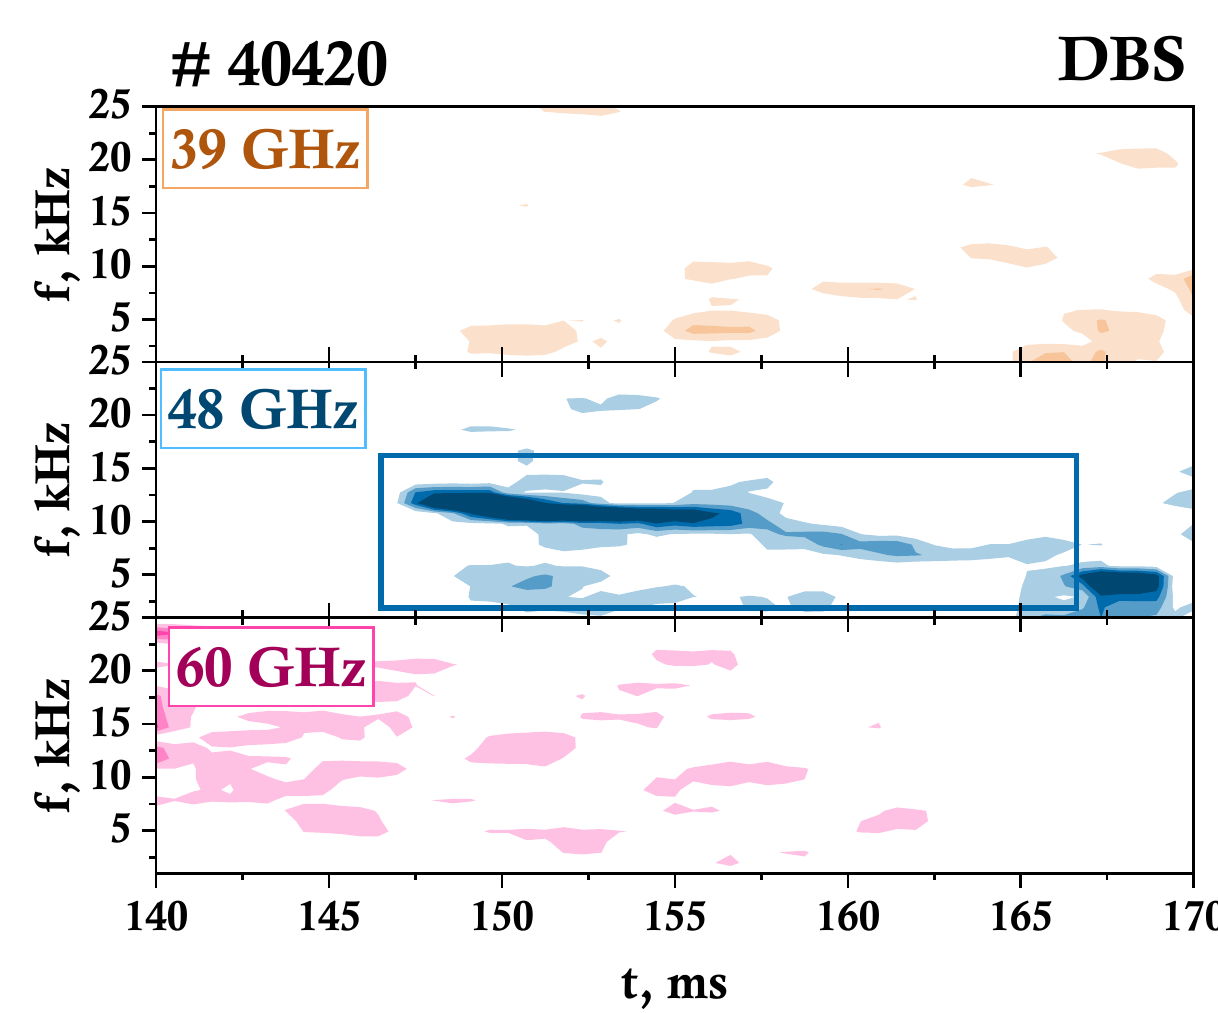
Figure 3. Spectrograms of the DBS phase derivative for discharge #40420.